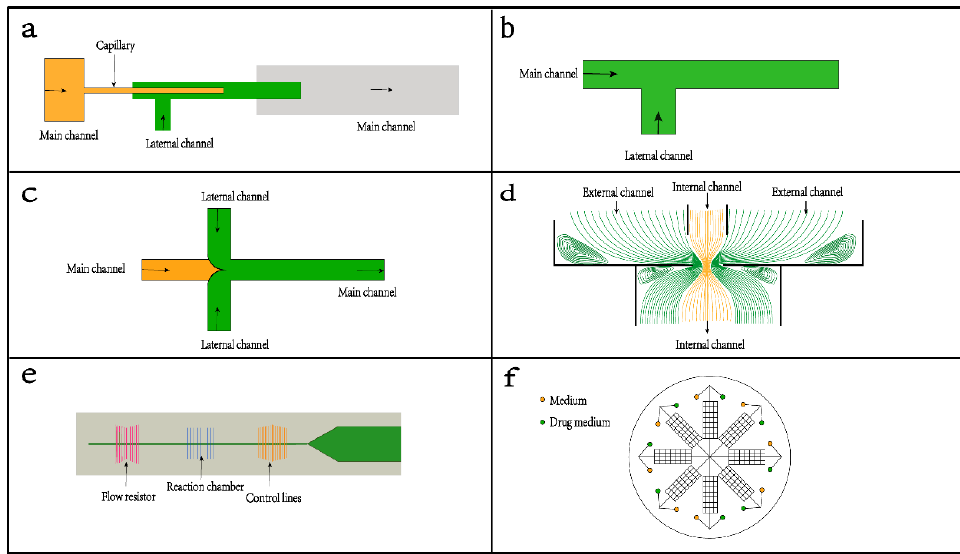
Figure 2. Microarrangements of platforms and devices in microfluidics: ( a ) a capillary-based platform that favors creating coaxial flows; three main arrangements in PDMS microfluidic chips: ( b ) T-junction, ( c ) cross-junction, and ( d ) concentric channel; and ( e , f ) two systems with a multichannel in a PDMS chip for analysis.